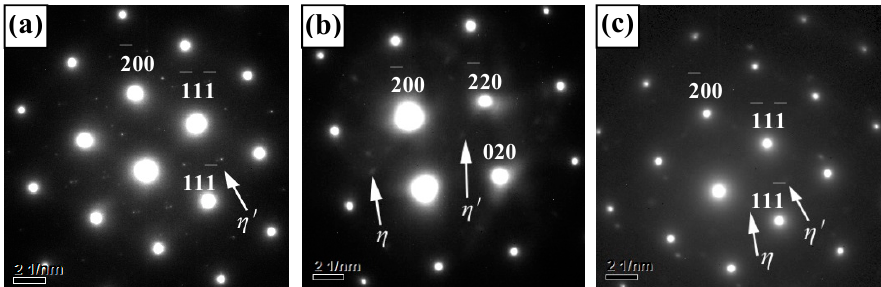
Figure 9. SAED (selected area electron diffraction) patterns of the weld center aged at different temperatures for 24 h ( a ) 120 °C <011>; ( b ) 130 °C <001>; ( c ) 140 °C <011>.